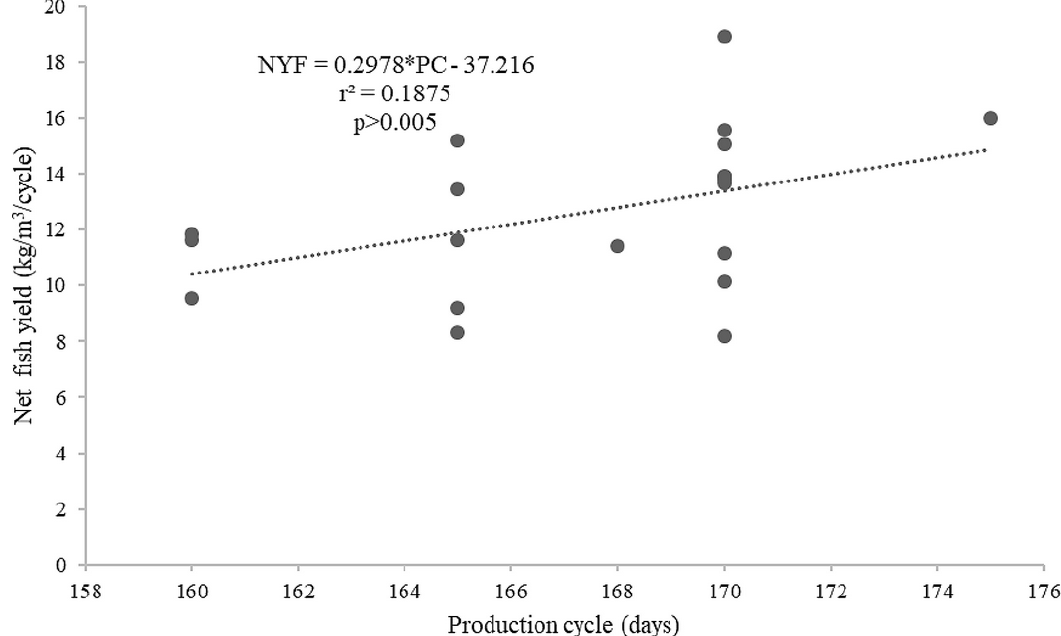
Figure 7. Production cycle and net fish yield (kg/m 3 /cycle) relationship for giant gourami reared in floating cages.